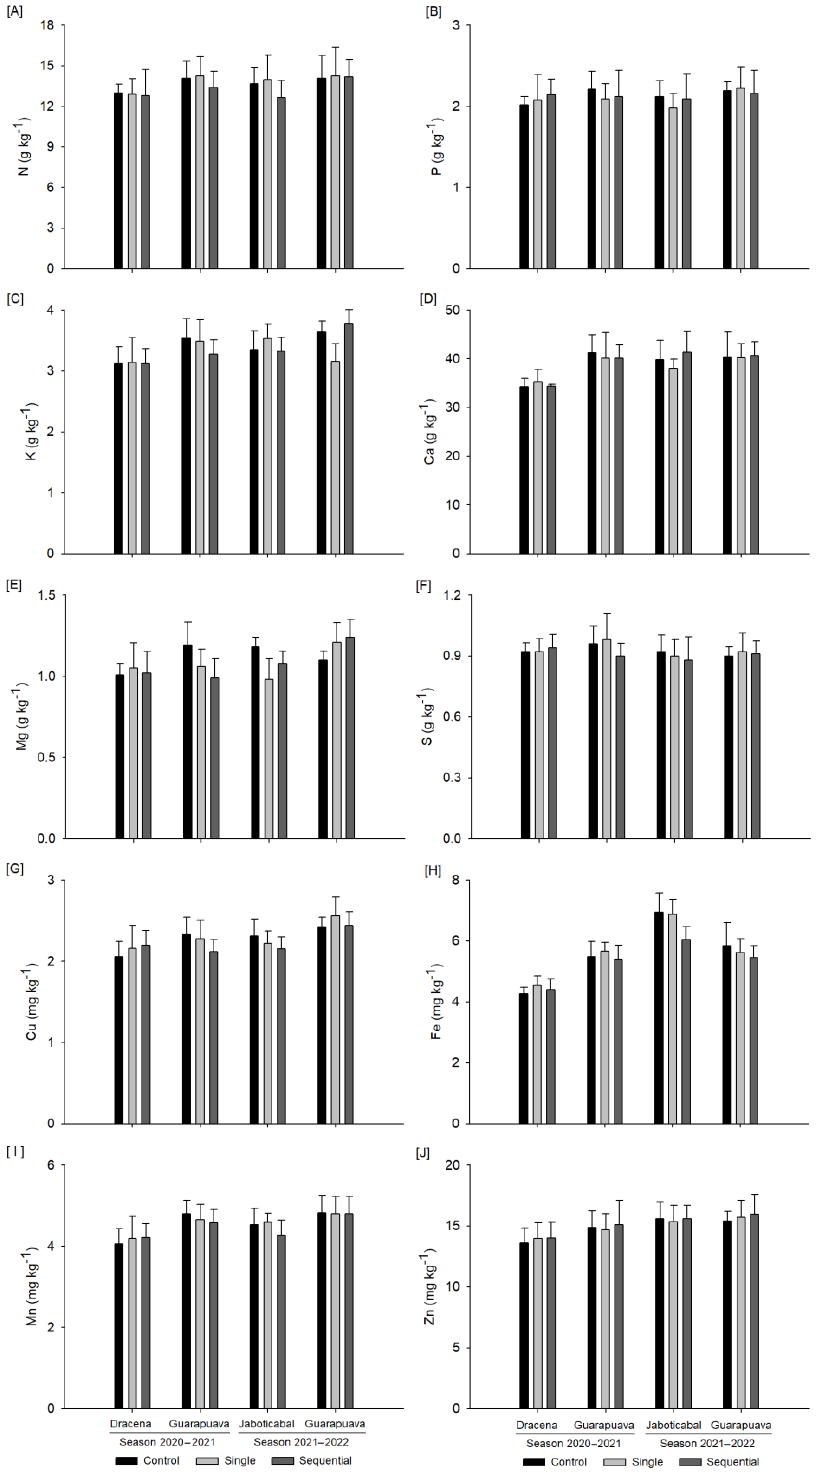
Figure 5. Content of macro (N, P, K, Ca, Mg, and S, respectively ( A – F )) and micronutrients (Cu, Fe, Mn, and Zn, respectively ( G – J )) in grain tissues of glyphosate-resistant maize growing with no herbicide application (control), with a single application of glyphosate at 980 g of a.e. ha − 1 at stage V5 (single) and a sequential application of glyphosate at 520 + 980 g of a.e. ha − 1 at stage V3 and stage V7, respectively (sequential), in different locations and seasons. Error bars are one SE of the mean from ten